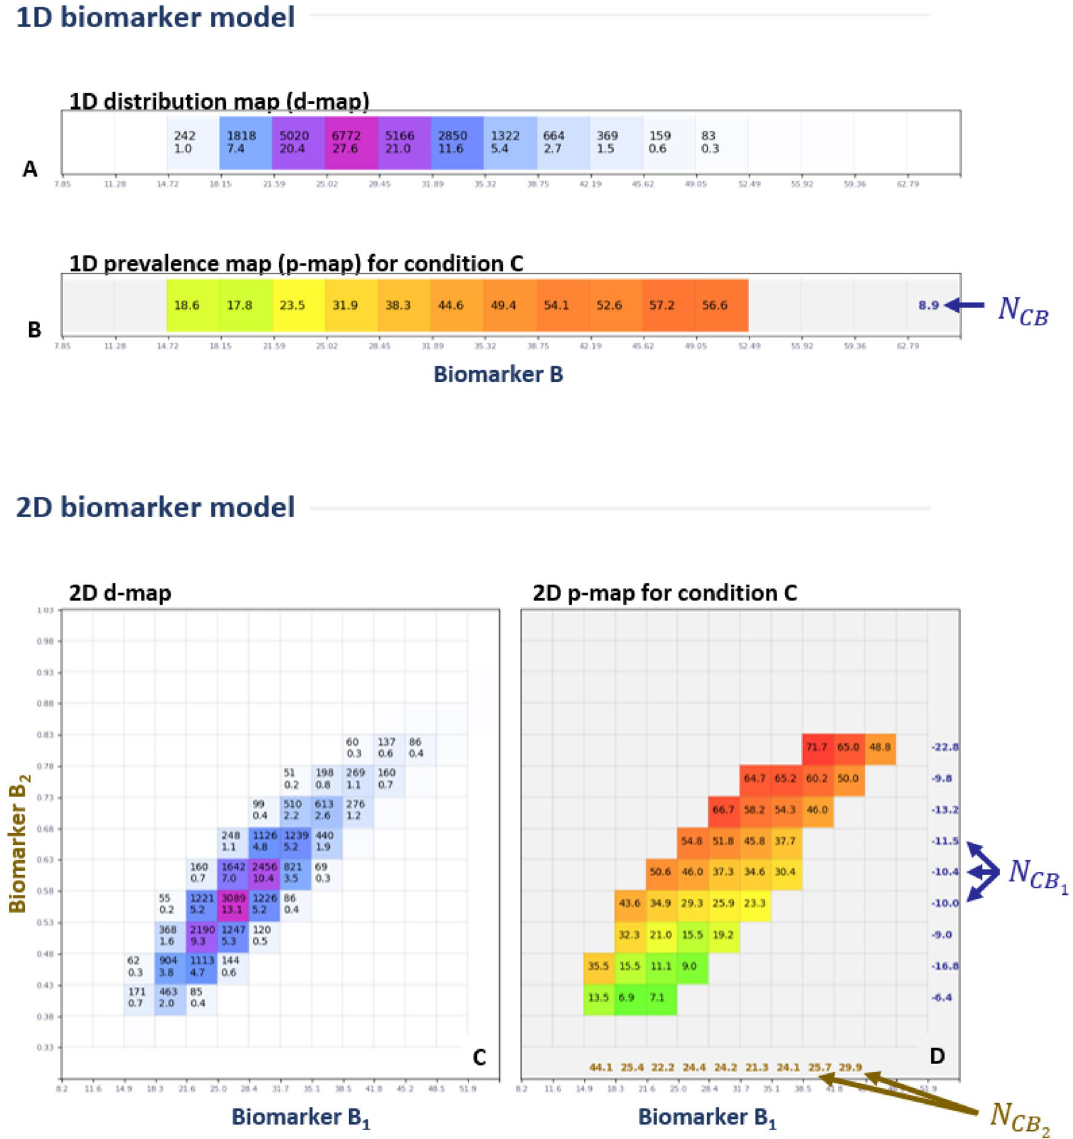
Figure 1. 1D and 2D biomarker models. ( A ) A 1D d-map for a given population. ( B ) The corresponding 1D p-map for a condition C of interest. ( C ) A 2D d-map for a given population. ( D ) The corresponding 2D p-map. NORSE scores are indicated at the end of each row and